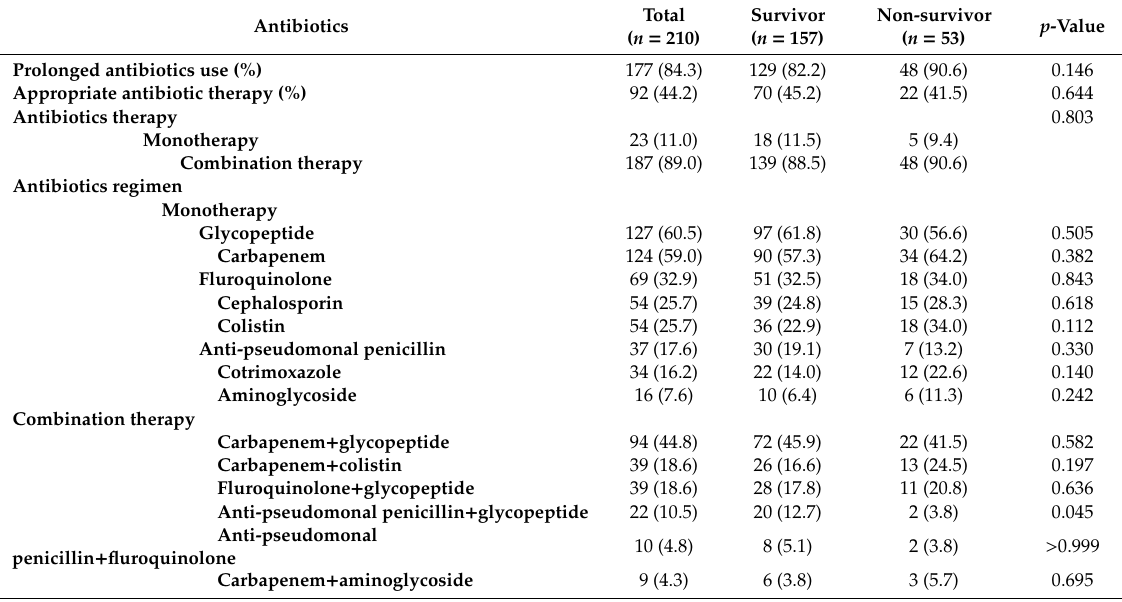
Table 4. Antimicrobial treatment regimen for 210 patients with Elizabethkingia spp.